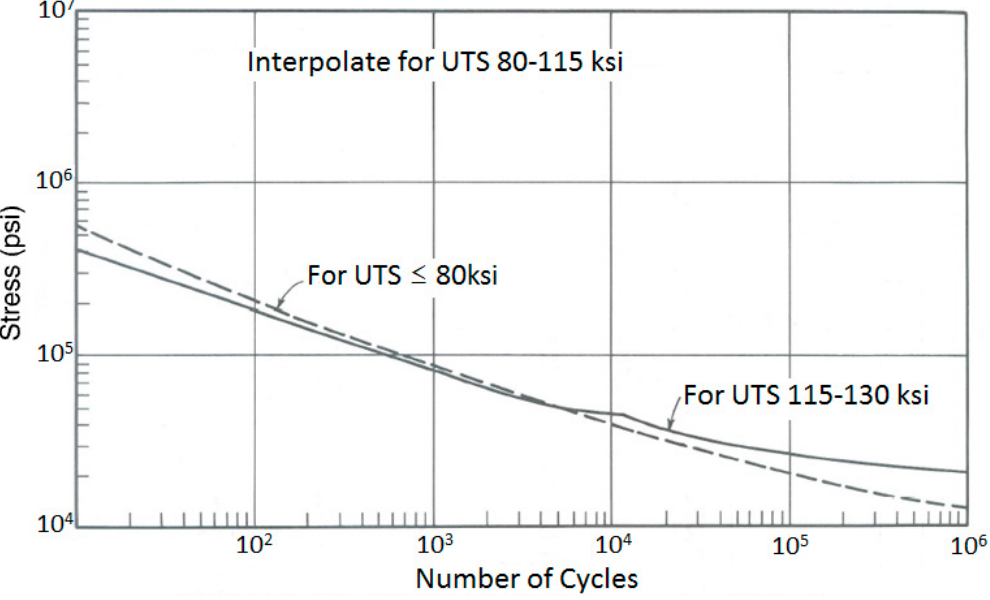
Figure 13. S–N curve for the material of the heater (ASTM A36, UTS = 58 ksi, or 400 MPa).